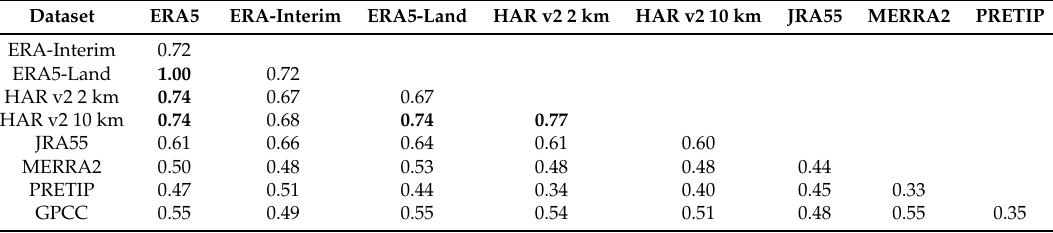
Figure 5. Spatial log-scaled per-grid-cell sum over the study period for each of the precipitation products. Sums were only calculated for valid values, which excluded the south-western corner in the PRETIP product (hatched area) and individual grid cells lower than 2500m.a.s.l. Table 4. Correlation coefficient R for all datasets in mm/day. The five highest correlations are highlighted with bold font. All correlations are statistically significant at the 99% confidence